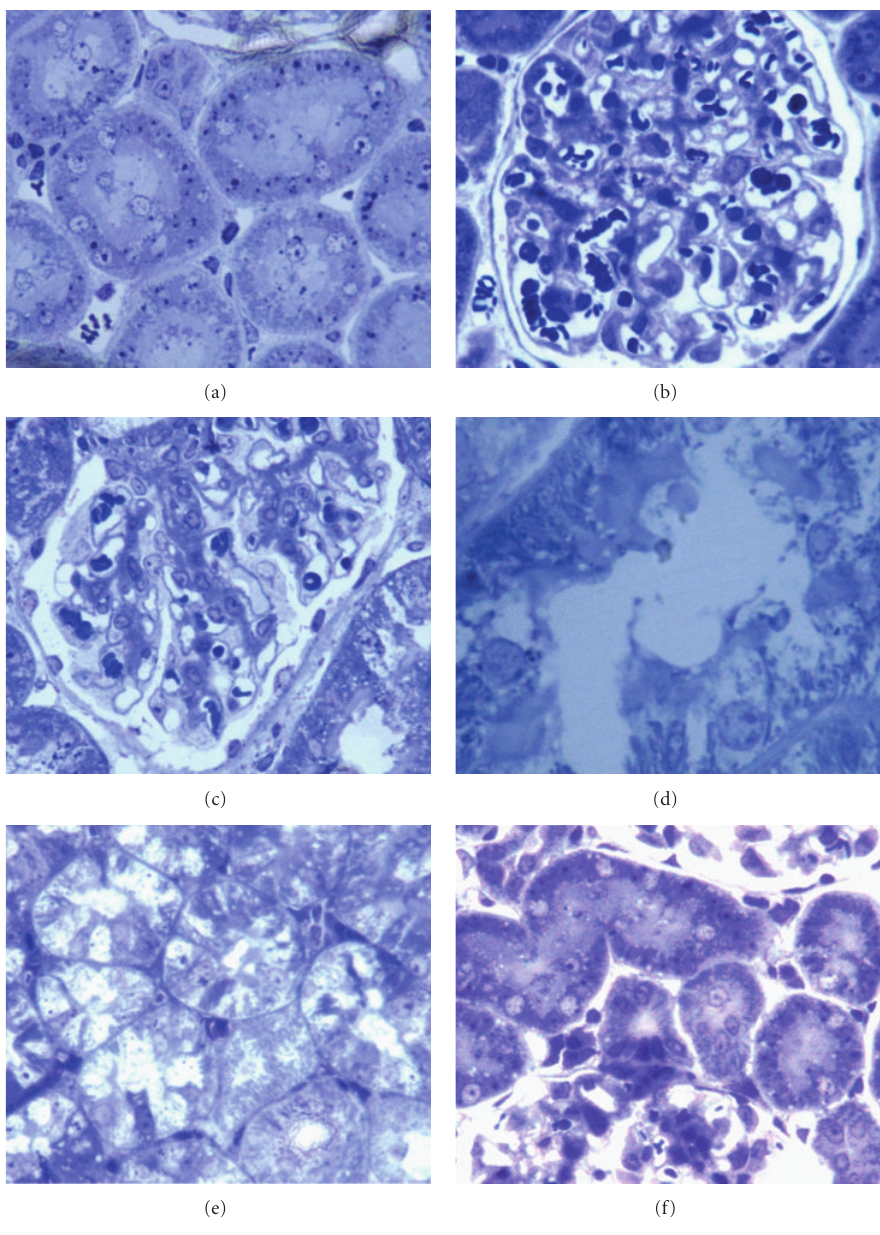
Figure 2: Control and nicotinamide (NAD), (a) and (b) toluidine blue × 40; doxorubicin (DXR); (c) toluidine blue × 40; (d) toluidine blue × 100; (e) toluidine blue × 40; DXR+NAD; (f) toluidine blue ×